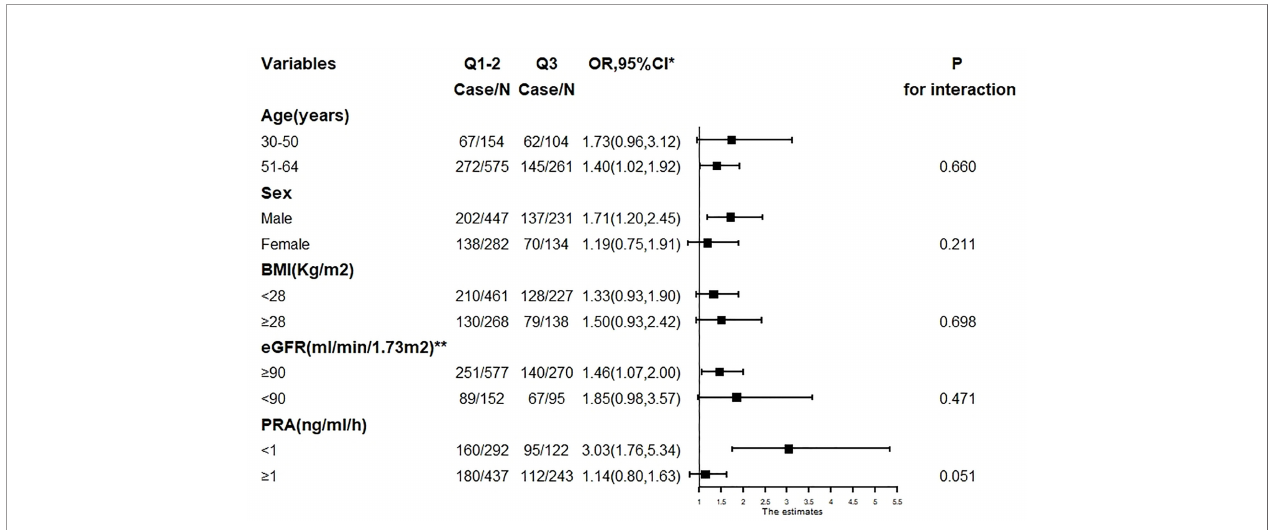
FIGURE 5 | The association between PAC (Q3 compared with Q1 – 2)and WMLsinvarious subgroups. PAC, plasma aldosterone concentration;WMLs, white matter lesions; BMI, bodymass index; Cr,creatinine; TC, totalcholesterol; TG,triglyceride; LDL-C, low-density lipoprotein-cholesterol; HDL-C, high-density lipoprotein-cholesterol; HbA1c, hemoglobin A1c; Hcy,homocysteine; ACTH, adrenocorticotrophichormone. *Adjusted,ifnot strati fi ed, for age, sex, BMI, Cr,smokingor alcohol consumption status, history of coronary artery disease or diabetes mellitus, TC, TG, LDL-C, HDL-C, HbA1c, Hcy, ACTH, cortisol,diastolicbloodpressure, systolicbloodpressure, duration of hypertension,and use of statins or antiplatelet agents. **ChronicKidney Disease Epidemiology Collaboration (CKD-EPI)